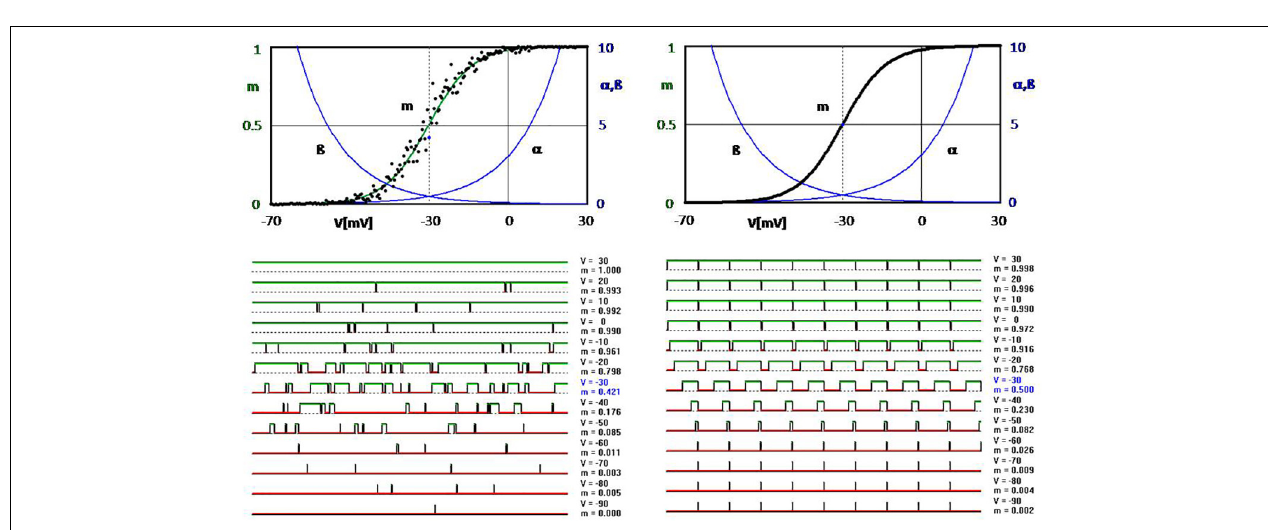
FIGURE 2 | Computer simulation of voltage-dependent opening and closing of ion channels (simplified approach according to Hodgkin and Huxley, 1952; see Tchaptchet et al., 2013). Upper diagrams: Exponential transition functions (rate constants) α and β with p = α /( α + β ) leading to the well-known Boltzmann function of the opening probability (all shown in green). The black dots scattering around it in the upper left-hand diagram are obtained when the transitions are determined by drawing random numbers in comparison to the values given by α and β . Some examples of this are shown in the graphs at the bottom left (over a 60-ms time axis with a calculation step size of 0.1 ms). The curves at the bottom right are obtained by determining the opening and closing times directly from the transition functions α and β without random factors. Accordingly, all points of the opening probability lie exactly on the Boltzmann curve in the upper right diagram, which then is completely covered by the black